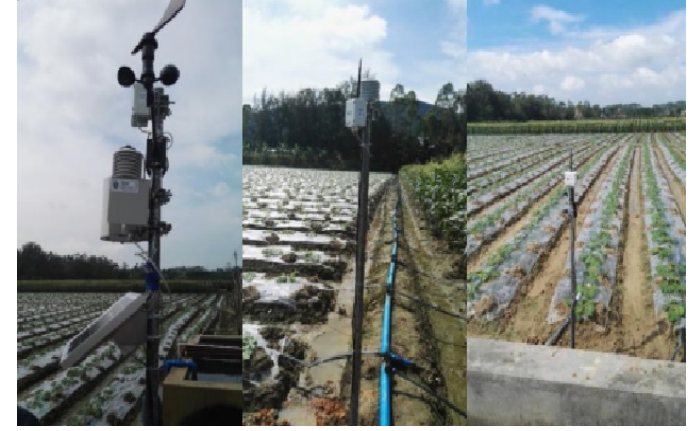
Figure 5. Sensor devices of Caipos.